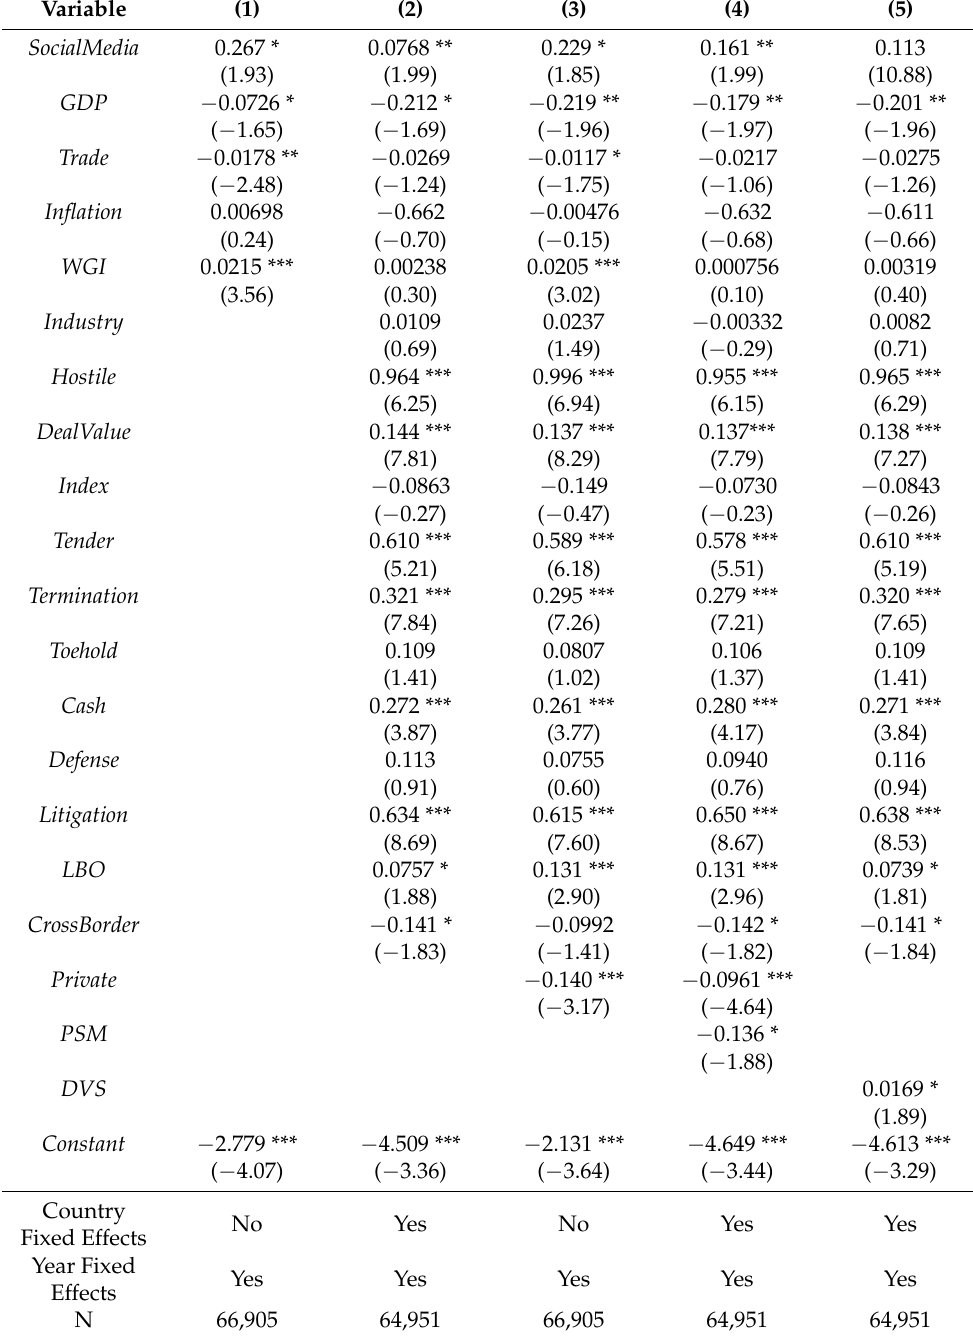
Table 7. This table presents the results of five probit regressions for the full sample of global M&A deals. The dependent variable is Compete, an indicator variable that equals 1 if the deal involved a competing bid and 0 otherwise. The independent variable is SocialMedia , an indicator variable that equals 1 if social media is popular in the target country j at time t. Model 1 includes macroeconomic control variables only. Models 2–5 include deal-level control variables in addition to the macroeconomic control variables. Standard errors are clustered by year in all models. Country and year fixed effects are included in models 2, 3 and